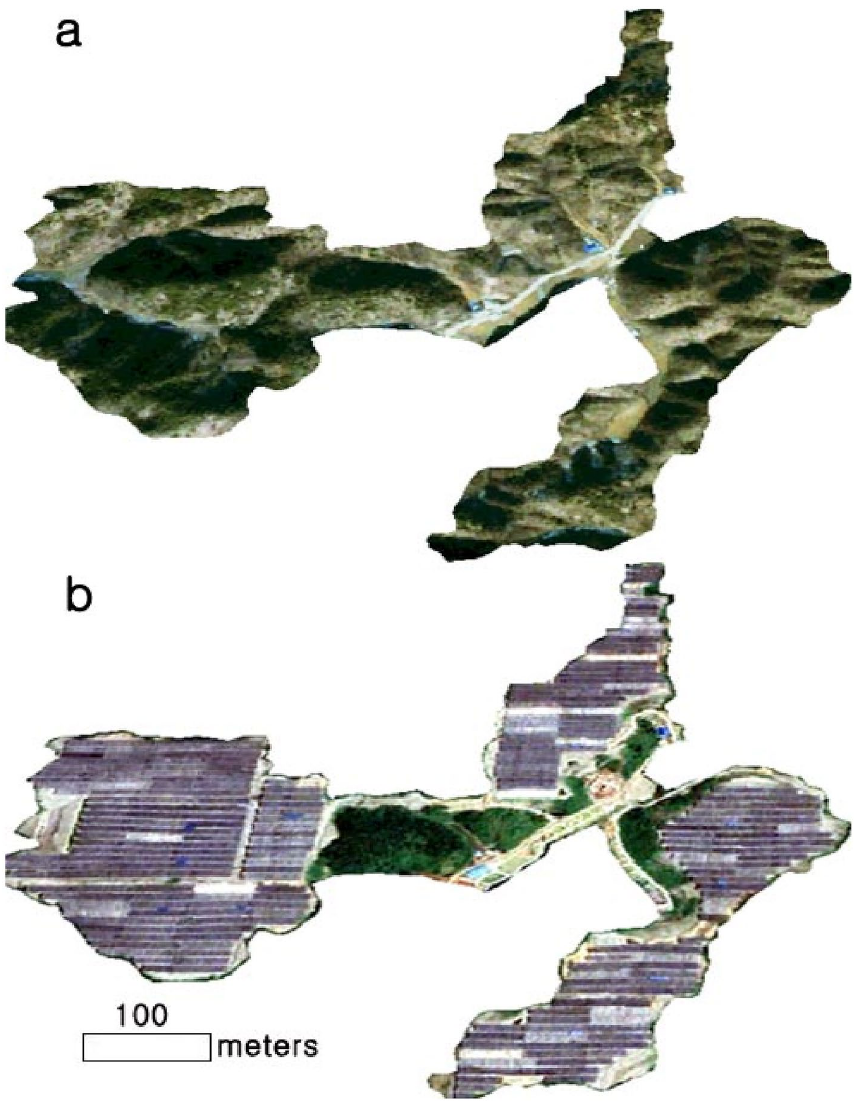
Figure 5. Comparison of forestry cover between the solar tree and agrophotovoltaic system, ( a ) forestry landscape before solar power plant construction ( b ) non-forestry landscape after agrophotovoltaic system construction. See Fig. 2 for the location of the image. Time series images (2005 and 2020) were obtained from Google Earth Pro 7.3.4 (https:// www. google. com/ earth/ versi ons/# earth- pro). The map created in Google Earth